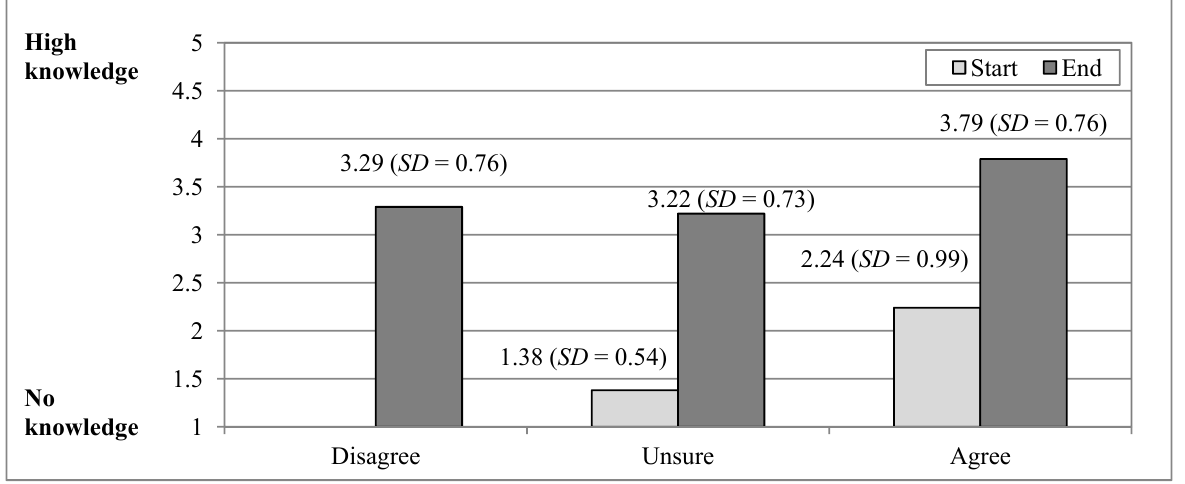
Figure 1. Mean self-ratings of knowledge of geothermal by attitude